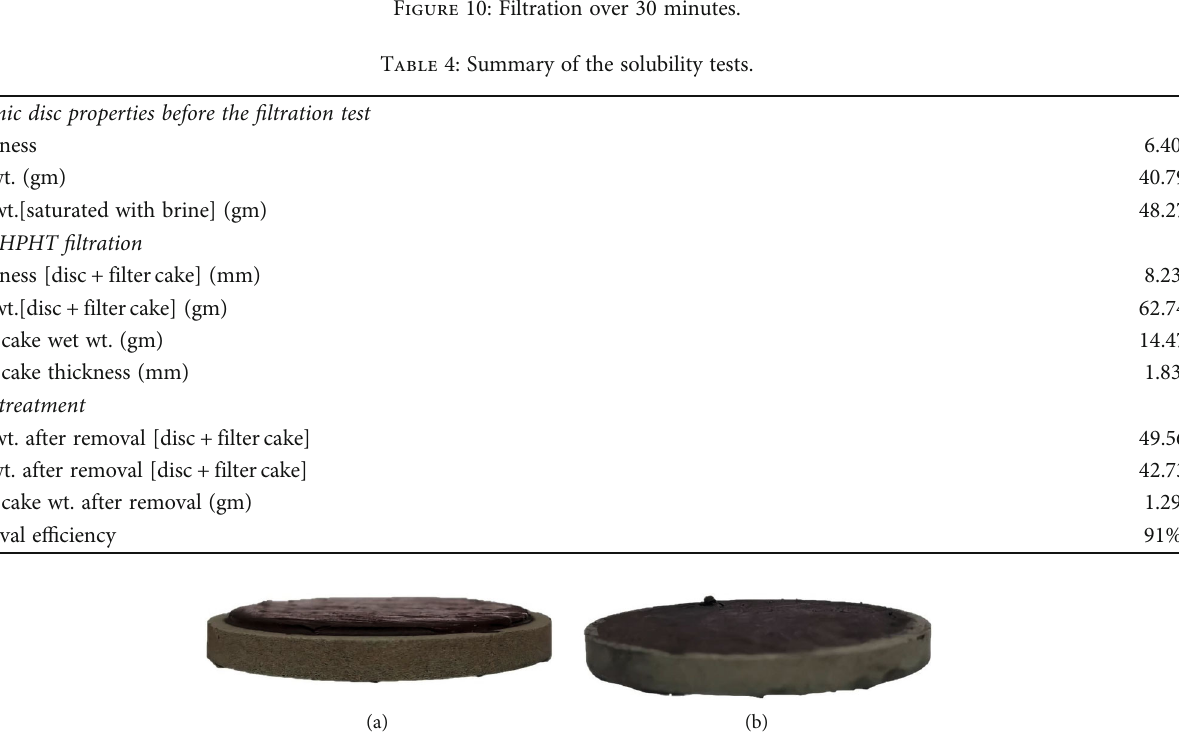
Figure 11: The fi lter cake: (a) after 30 minutes of drilling fl uid fi ltration and (b) after soaking in 12.5%